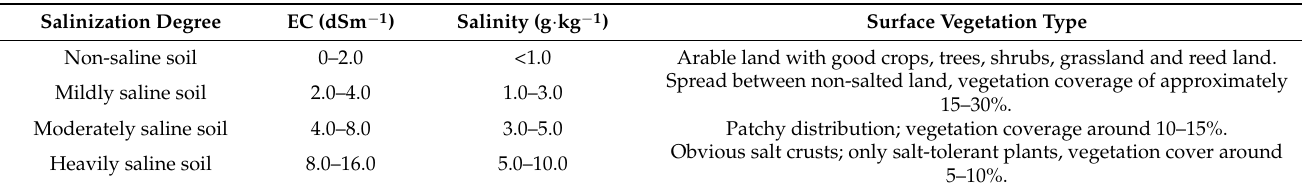
Table 1. Classification system of salinization.